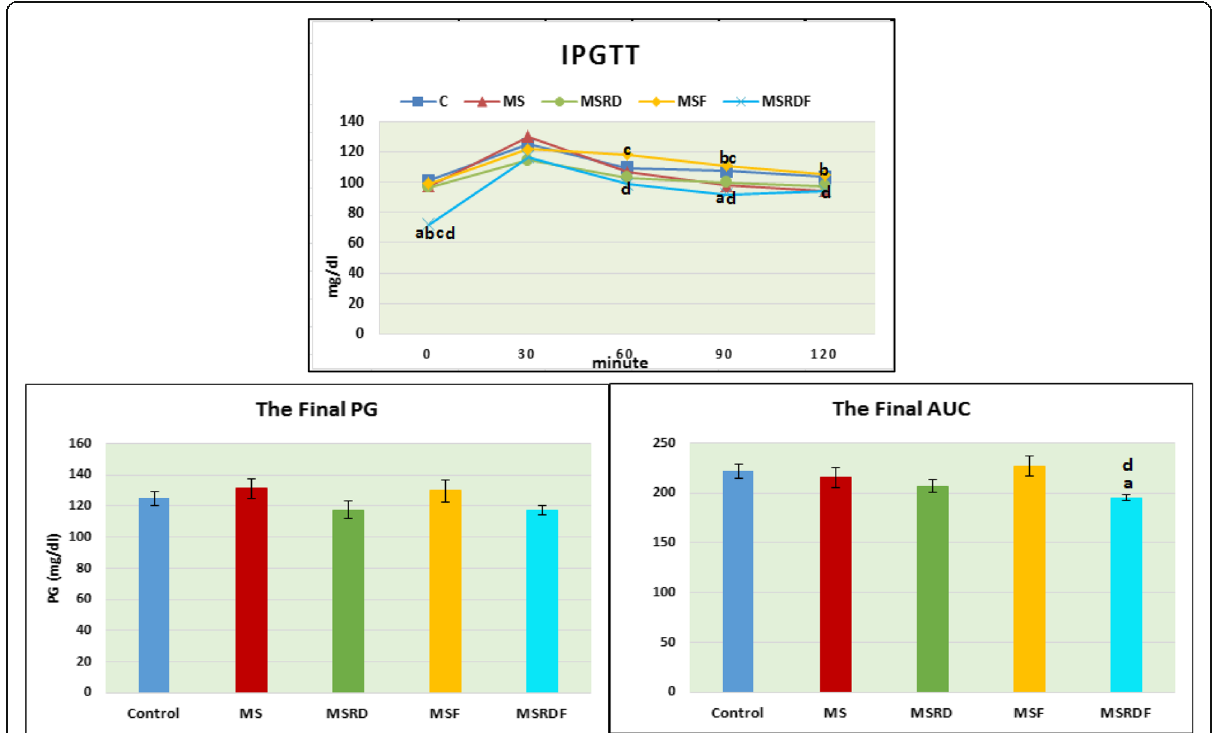
Fig. 5 The final glucose homeostasis parameters in the five study groups. MS untreated metabolic syndrome group, MSRD metabolic syndrome group reverted to regular rat chow, MSF metabolic syndrome group on alternate day fasting, MSRDF metabolic syndrome group reverted to regular rat chow and on alternate day fasting, IPGTT intraperitoneal glucose tolerance test, PG peak glycemia, AUC area under the curve. Data are expressed as mean ± SEM. a: Significance from control group, by LSD test at P ≤ 0.05. b: Significance from MS group, by LSD test at P ≤ 0.05. c: